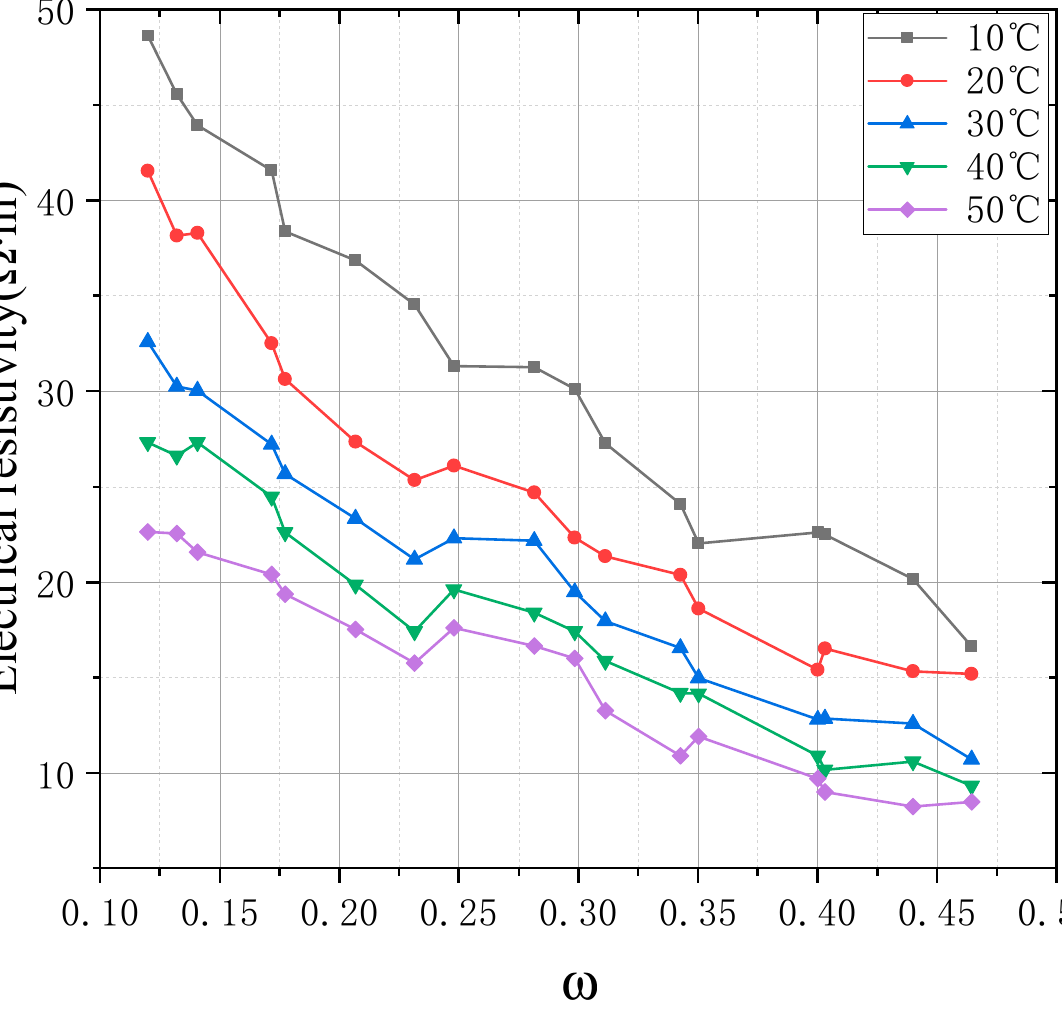
Figure 4. Variation in resistivity with water content under different temperature conditions.